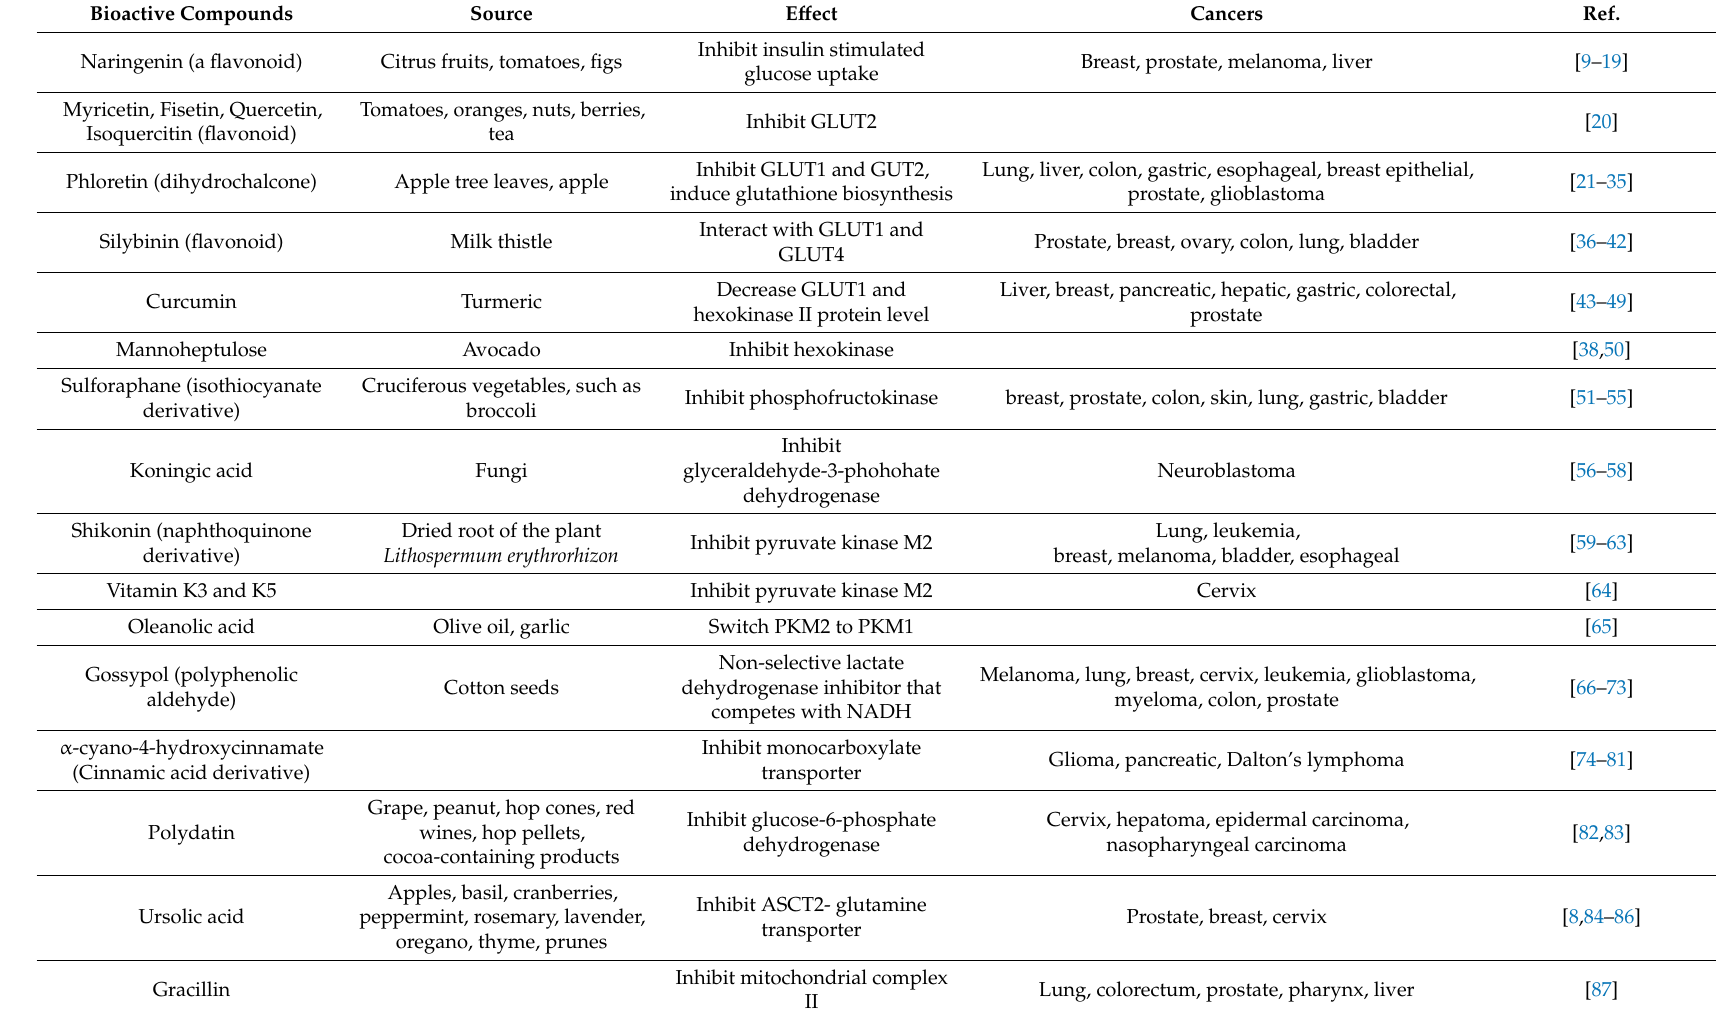
Table 1. E ff ect of bioactive compounds on di ff erent metabolic